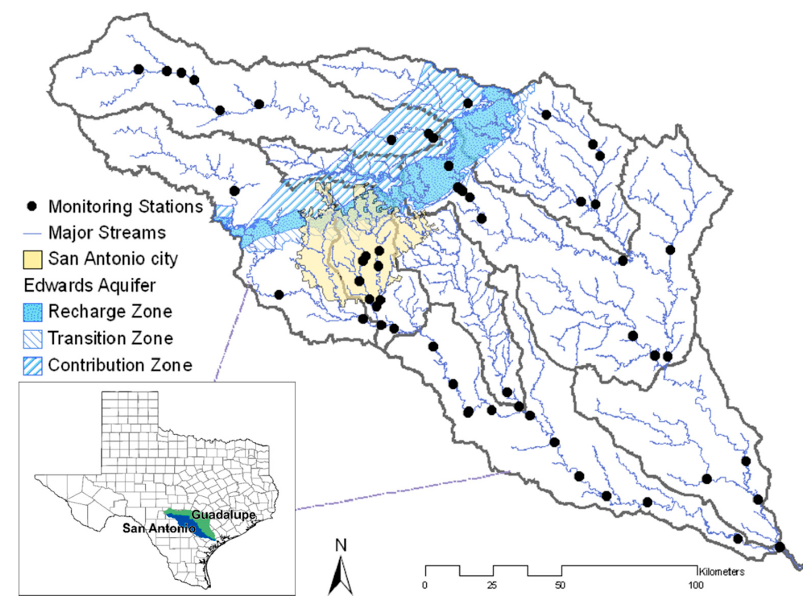
Figure 1. Monitoring stations and major streams in the Guadalupe and San Antonio River Basins.